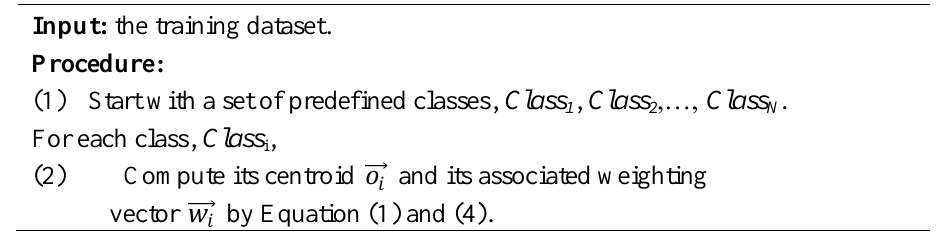
Table 2. The testing stage of